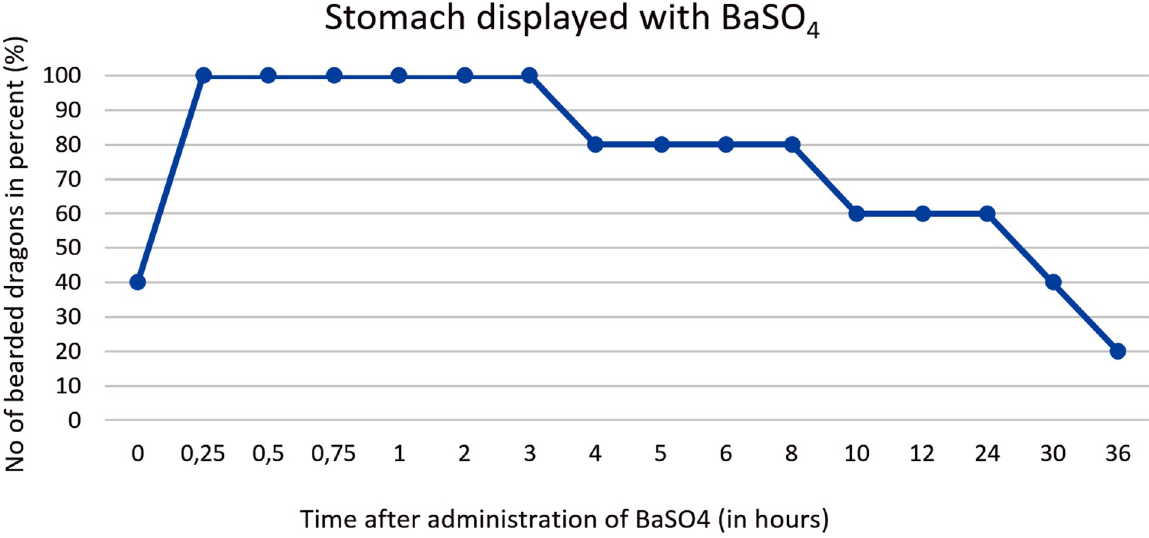
Fig 10. BaSO 4 contrast visibility in the stomach over time. Percentage of animals and frequency at measuring time point; y = number of animals in percent (%) in which contrast media could be found in the stomach; x = time point during the BaSO 4 contrast passage (hours).